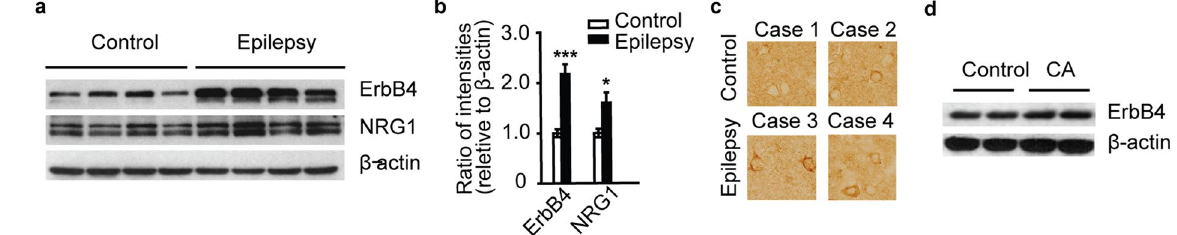
Figure 2. The expression of neuregulin 1 (NRG1) and ErbB4 in human symptomatic epileptic tissues. ( a ) Immunoblotting shows increased ErbB4 and NRG1 protein expression in the temporal cortex of symptomatic epilepsy patients. ( b ) Quantification of NRG1 and ErbB4 immunoblots (n = 12). ( c ) DAB staining shows increased ErbB4 immunoreactivity in symptomatic epileptic tissues. ( d ) Representative western blots of ErbB4 in cavernoma patients with and without symptomatic seizure and epileptiform discharge. Cavernoma patients without symptomatic seizure and epileptiform discharge (CA). * P < 0.05; *** P < 0.001. Unpaired two-tailed Student’s t-test. Data are represented as the mean ± s.e.m.